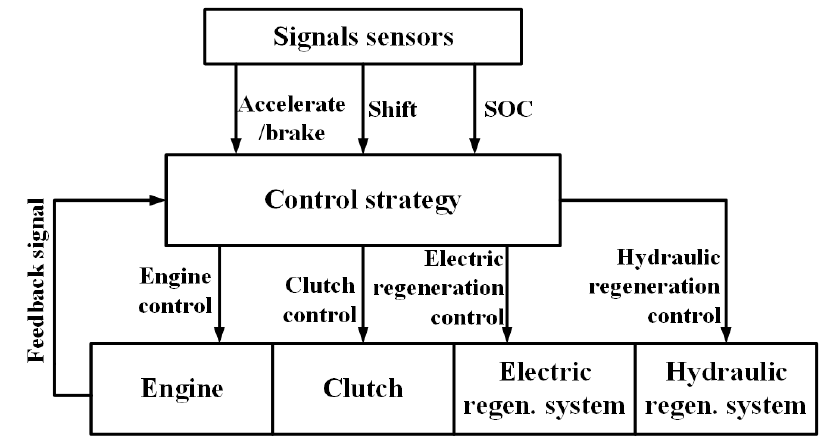
Figure 72. Operating principle of the control system proposed by Hui et al. The control strategy drives the actuating systems according to the decisions made from the sensor inputs. Adapted from [181].